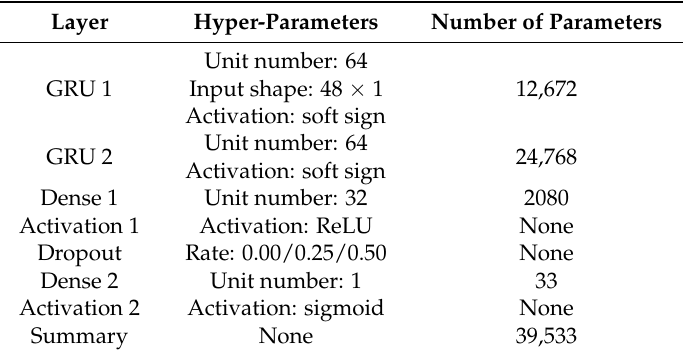
Table 2. The structure of the proposed GRU